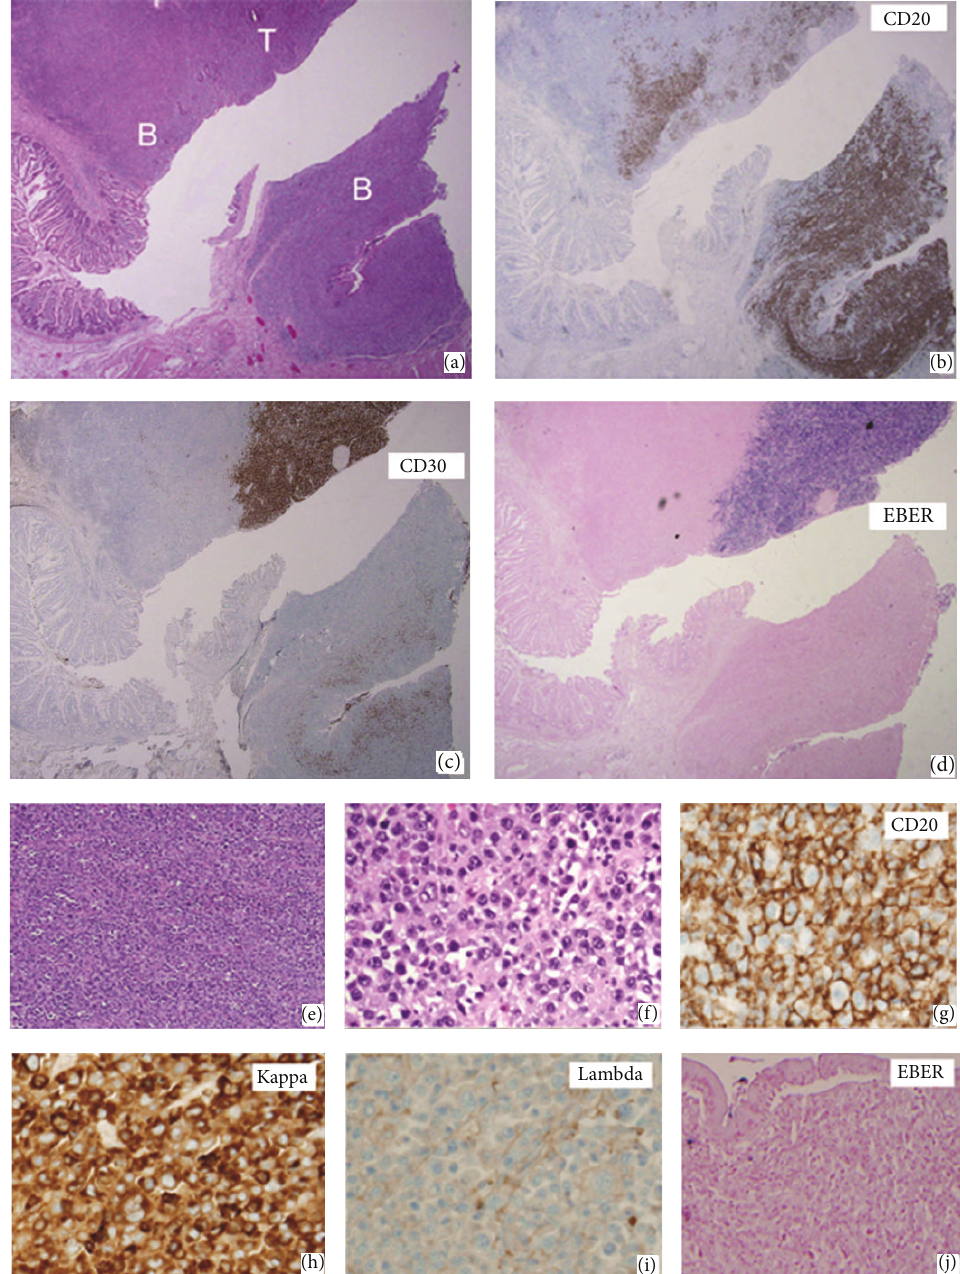
Figure 2: Two distinct components of the lymphoma can be seen in this area of the tumor. (a) H&E section of two distinct components of this lymphoma (20x) with B-cell-like areas marked “B” and T/anaplastic area marked “T.” (b) CD20 stains a distinct area (20x). (c) CD30 positive area is largely CD20 negative (20x). (d) EBER is negative in CD20 positive area (20x). (e) H&E section shows neoplastic lymphoid proliferation in the CD20 positive area (100x). (f) The neoplastic lymphoid cells in CD20 positive area are somewhat less pleomorphic and have fewer multinucleated tumor cells (H&E, 400x). (g) High power view of CD20 positive cells (400x). (h) Positive staining for Kappa light chain (400x). (i) Negative staining for Lambda light chain (400x). (j) Negative EBER by in situ hybridization